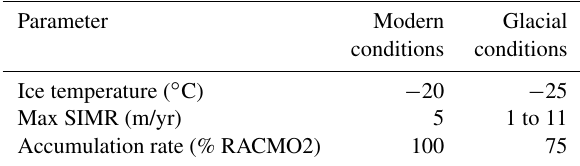
Table 1. Parameter values used for sensitivity experiments indicat- ing choices for model tuning to modern conditions over a spin-up period. Glacial conditions are parameter values used to simulate deglaciation. SIMR: sub-ice-shelf melt rate. Accumulation values reported as percentage of RACMO2 (van Wessem et al., 2018). Parameter Modern Glacial conditions